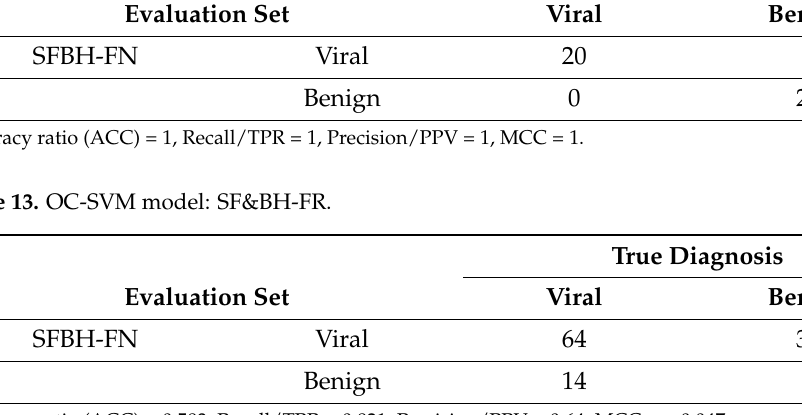
Table 14. C-SVM model: SF&BH-BN. True Diagnosis Evaluation Set Viral Benign SFBH-BN Viral 20 0 Benign 0